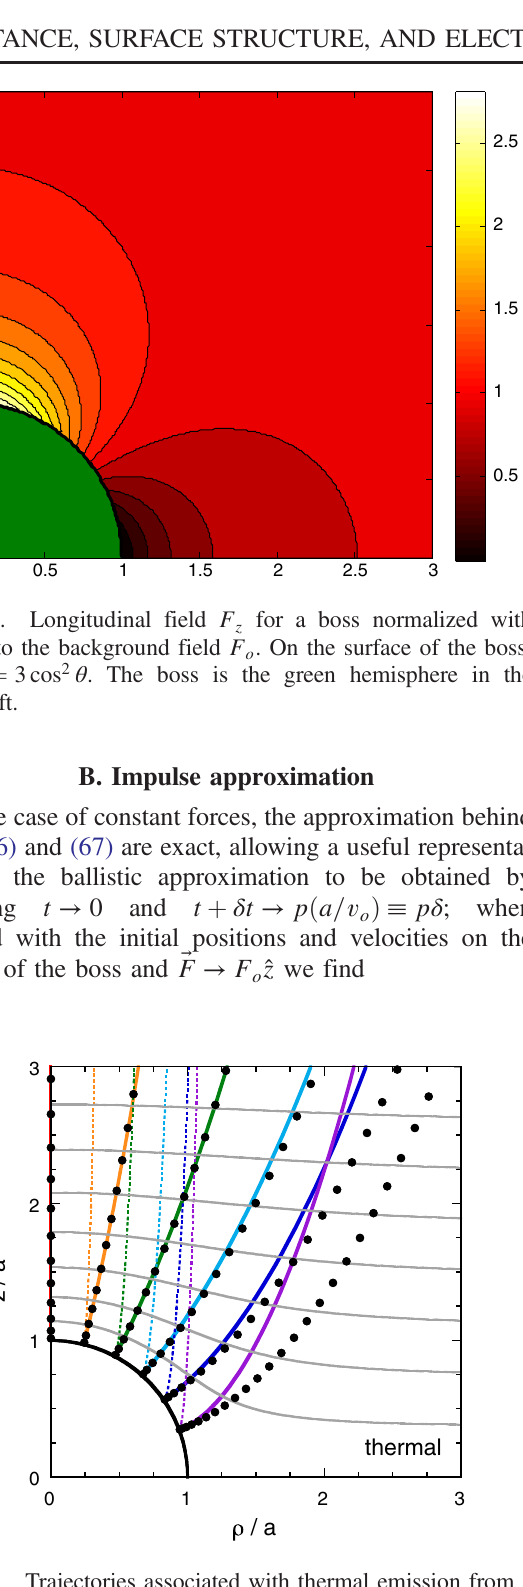
FIG. 12. Trajectories associated with thermal emission from a hemispherical boss without (dashed lines) and with (solid lines) the impulse approximation, compared to numerically evaluated trajectories (solid dots) for thermal emission using Table III parameters. The (purple) last line is launched from the notional angle θ . Gray lines correspond to equipotentials equally spaced o in energy.